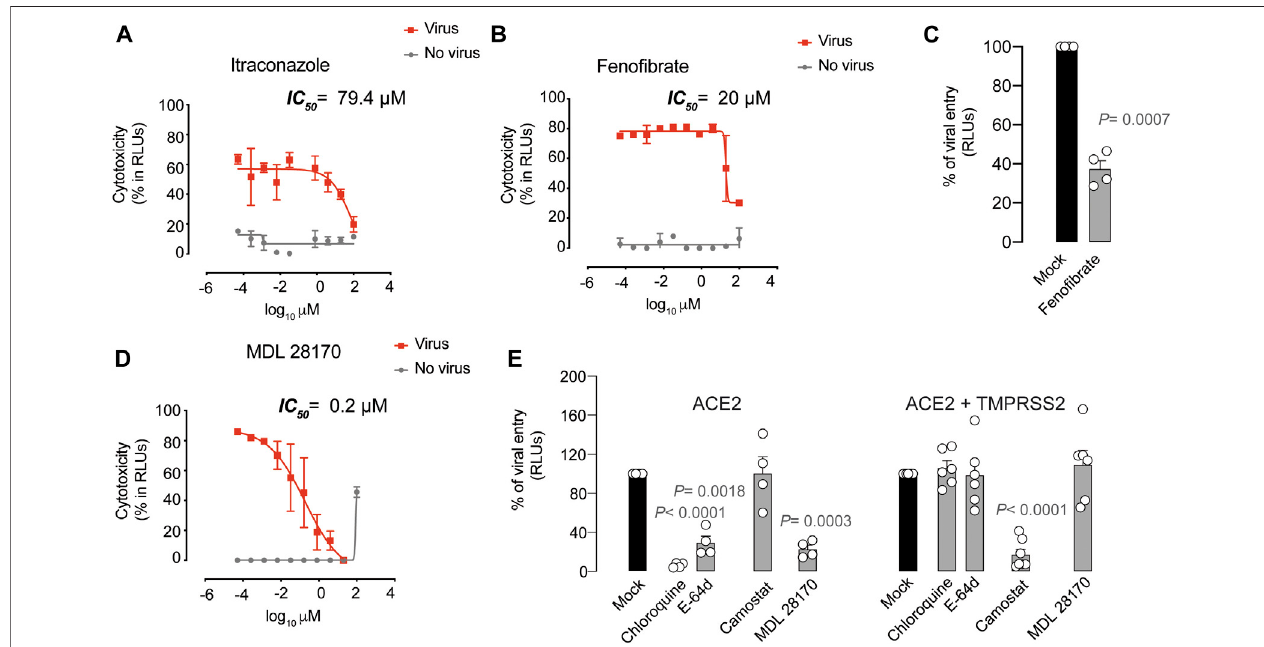
FIGURE 3 | Antiviral activity of inhibitors with unknown mechanism of action. (A) . Cytopathic effect on Vero E6 cells exposed to a fi xed concentration of SARS-CoV-2 in the presence of increasing concentrations of Itraconazole. Drug was used at a concentration ranging from 0.0512 nM to 100 µ. Non-linear fi t to a variable response curve from one representative experiment with two replicates is shown (red lines), excluding data from drug concentrations with associated toxicity. The particular IC 50 value of this graph is indicated. Cytotoxic effect on Vero E6 cells exposed to increasing concentrations of drugs in the absence of virus is also shown (grey lines). (B) . Cytopathic effect on Vero E6 cells exposed to a fi xed concentration of SARS-CoV-2 in the presence of increasing concentrations of Feno fi brate, as detailed in (A) . (C) . Effect of feno fi brate on the entry of luciferase expressing lentiviruses pseudotyped with SARS-CoV-2 Spike in ACE2-expressing HEK-293T cells. Values arenormalized toluciferase expressionbymock-treatedcellssetat100%.Meanand s.e.m. fromtwoexperimentswithtworeplicates. Statisticaldeviationsfrom 100% were assessed with a one sample t test. (D) . Cytopathic effect on Vero E6 cells exposed to a fi xed concentration of SARS-CoV-2 in the presence of increasing concentrationsofMDL28170, asdetailedin (A) . (E) .Comparison ofMDL28170 activity withentryinhibitorsblocking viralendocytosis, such aschloroquine andE-64d, andinhibitorsblockingserineproteaseTMPRSS2,suchascamostat.ACE2expressingHEK-293TcellstransfectedornotwithTMPRSS2wereexposedtoSARS-CoV- 2 Spike lentiviruses in the presence of these compounds. Values are normalized to luciferase expression by mock-treated cells set at 100%. Mean and s.e.m. from at least two experiments with two replicates. Statistical deviations from 100% were assessed with a one sample t test.